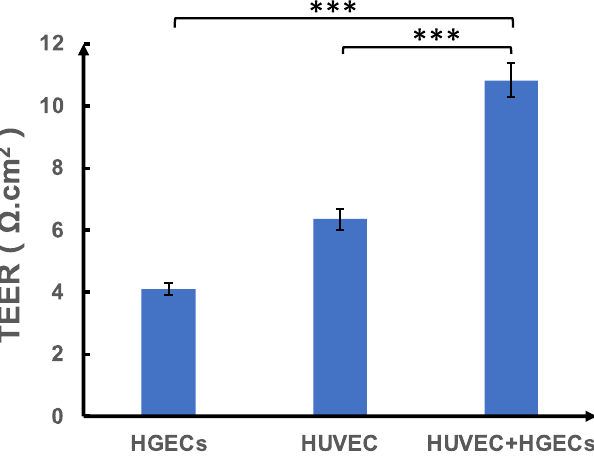
Figure 3. TEER-measurements in HGECs, HUVEC cells, and co-culture of HGECs and HUVEC cells. Results are mean ± SD from three or more experiments and data are analyzed by two tailed student’s t -test *** p < 0.001 compared with the monolayer.